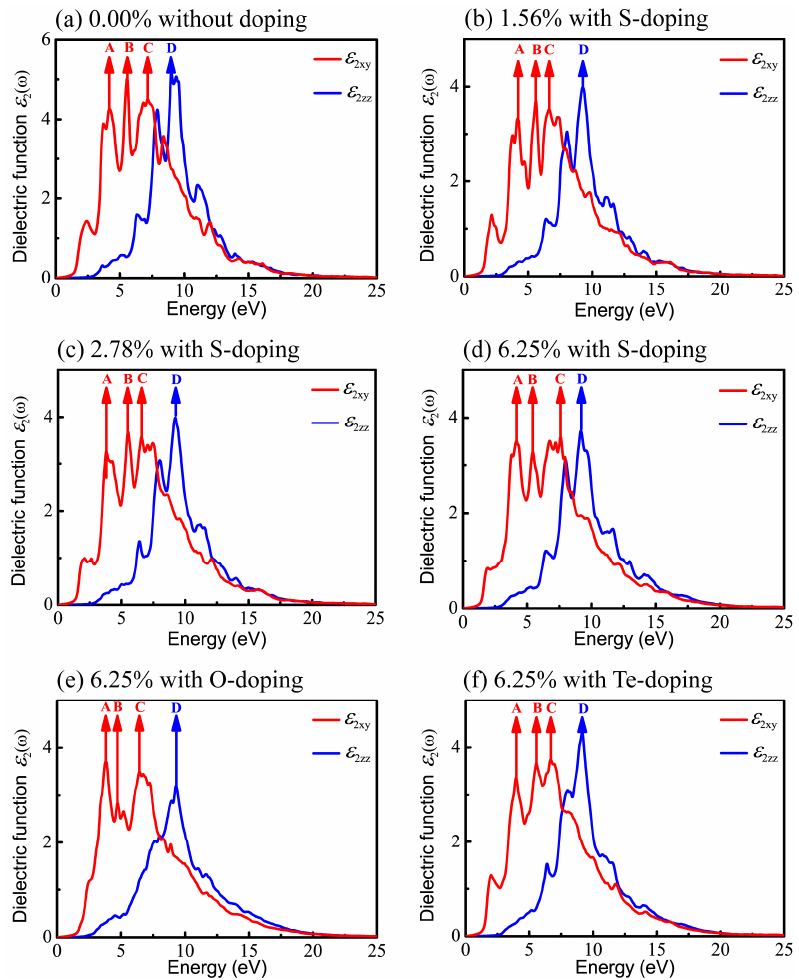
Figure 8. Imaginary parts of dielectric function ε 2 ( ω ) in xy plane and along z direction, versus photon energy: ( a ) pristine monolayer CSe; ( b – d ) S-doping at concentrations of 1.56%, 2.78%, and 6.25%, respectively; ( e ) O-doping at 6.25%; ( f ) Te-doping at 6.25%.